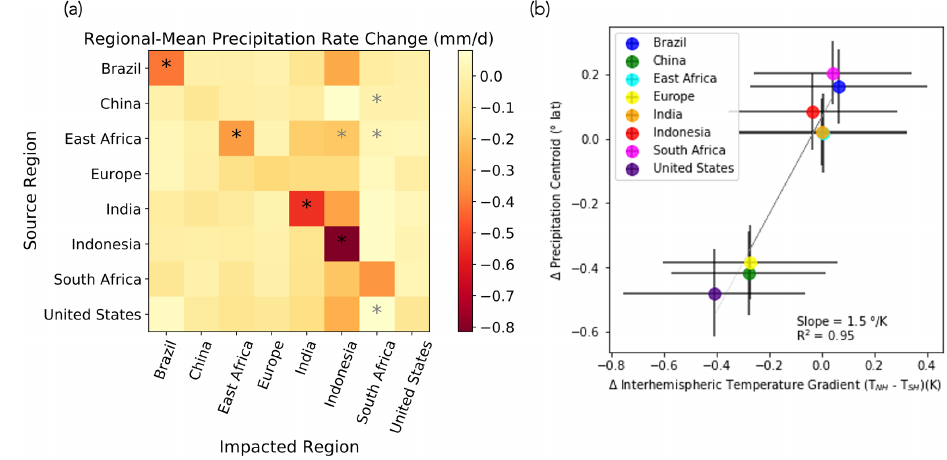
Figure 4. (a) Regional-mean changes in precipitation rate (mmd − 1 ) in each of the eight regions (columns) due to emissions from each of the eight regions (rows) are shown. (b) Shifts in the location of the Intertropical Convergence Zone, quantified as the change in the meridional centroid of zonally averaged precipitation between 20 ◦ S and 20 ◦ N ( ◦ latitude, y axis), correlate with the change in interhemispheric temper- ature gradient, quantified as the differences between Northern Hemisphere (NH) and Southern Hemisphere (SH) mean surface temperature (K, x axis). Error bars in panel (b) provide the 95% confidence interval ( ± 1 . 96 σ ). Black asterisks in panel (a) indicate regional-mean precip- itation changes that are significantly different than zero with 95% confidence. Grey asterisks in panel (a) indicate regions with no statistically significant precipitation response in any grid cell; all others show statistically significant precipitation responses in some grid boxes within the region (see Fig. 1), although the regional-mean change is not statistically